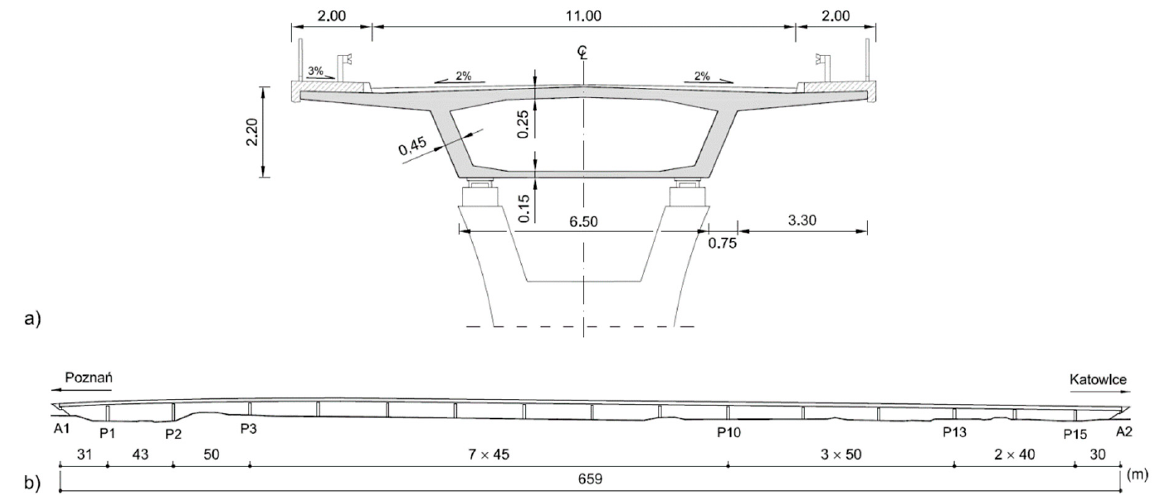
Figure 2. Cross-section ( a ) and side view ( b ) of high-performance concrete post-tensioned viaduct as a concept of the B ą ków bypass on highway DK11 [51].